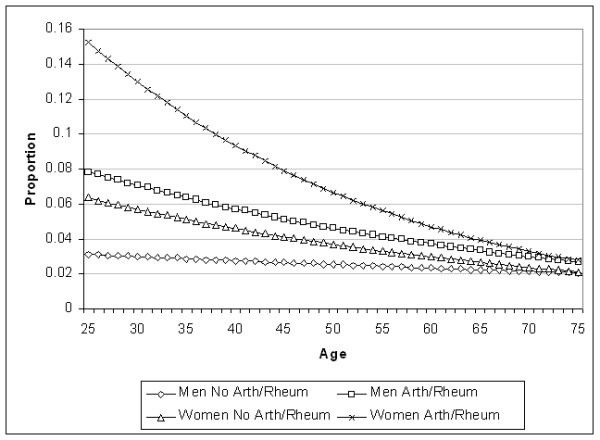
Fitted proportions: logistic regression model for major depression. The logistic equation is: ln(odds major depression = -3.22 + 1.33 (Arth/Rheum) - 0.0087 (Age) + 1.11 (female sex) - 0.014 (Arth/Rheum by Age) - 0.014 (Age by Sex). Fitted proportions: odds/1 + odds